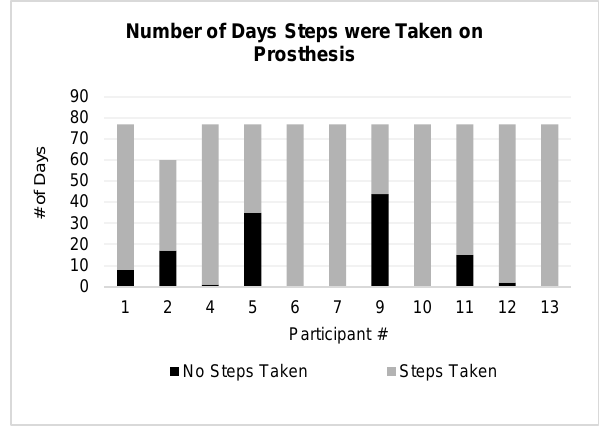
Figure 2: Number of days that participants took steps with their prosthesis. Black represents days with no steps taken and grey represents days with steps